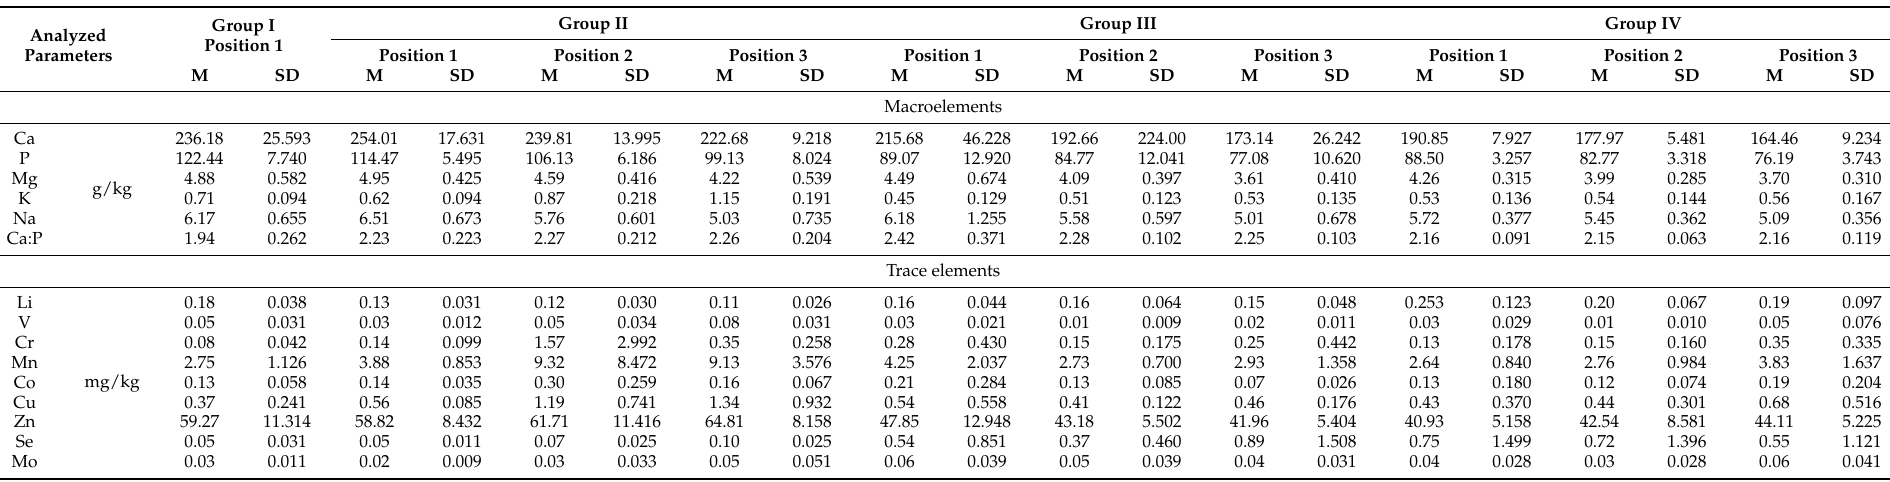
Table 2. Mean concentration (M) and standard deviation (SD) of macroelements and trace elements in the 1st, 2nd and 3rd positions of antlers (0.007 mg/kg < LOD < 0.099 mg/kg), and age, body mass and antler mass of farmed fallow